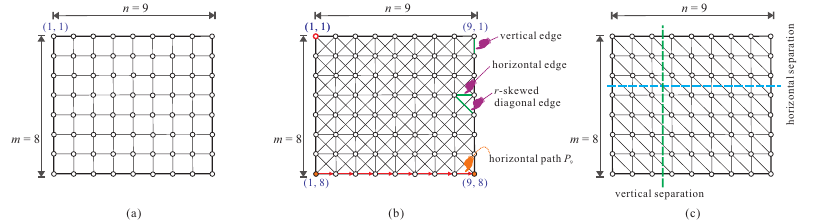
Figure 3. ( a ) A rectangular grid graph G 8 × 9 , ( b ) a rectangular supergrid graph R 8 × 9 , and ( c ) a rectangular triangular-supergrid graph T 8 × 9 , where the set of eight arrow lines in ( b ) indicates a horizontal path P 9 and the bold dashed lines in ( c ) indicate vertical and horizontal separations on T 8 × 9